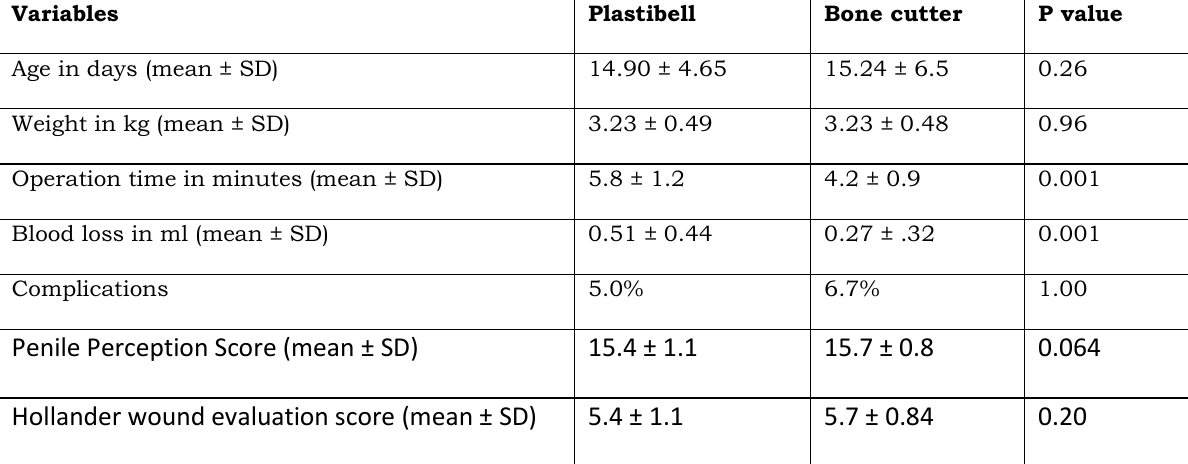
Table 1: Demographic characteristics, operating time, volume of blood loss and cosmetic